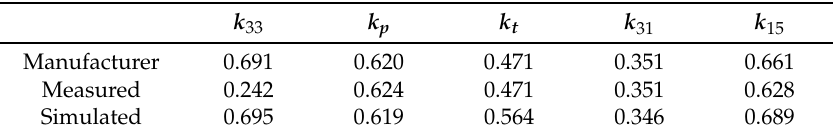
Table 1. Comparison of the PIC 255 electromechanical coupling factors ( k ) from the manufacturer datasheet, experimental measurements, and numerical simulations.